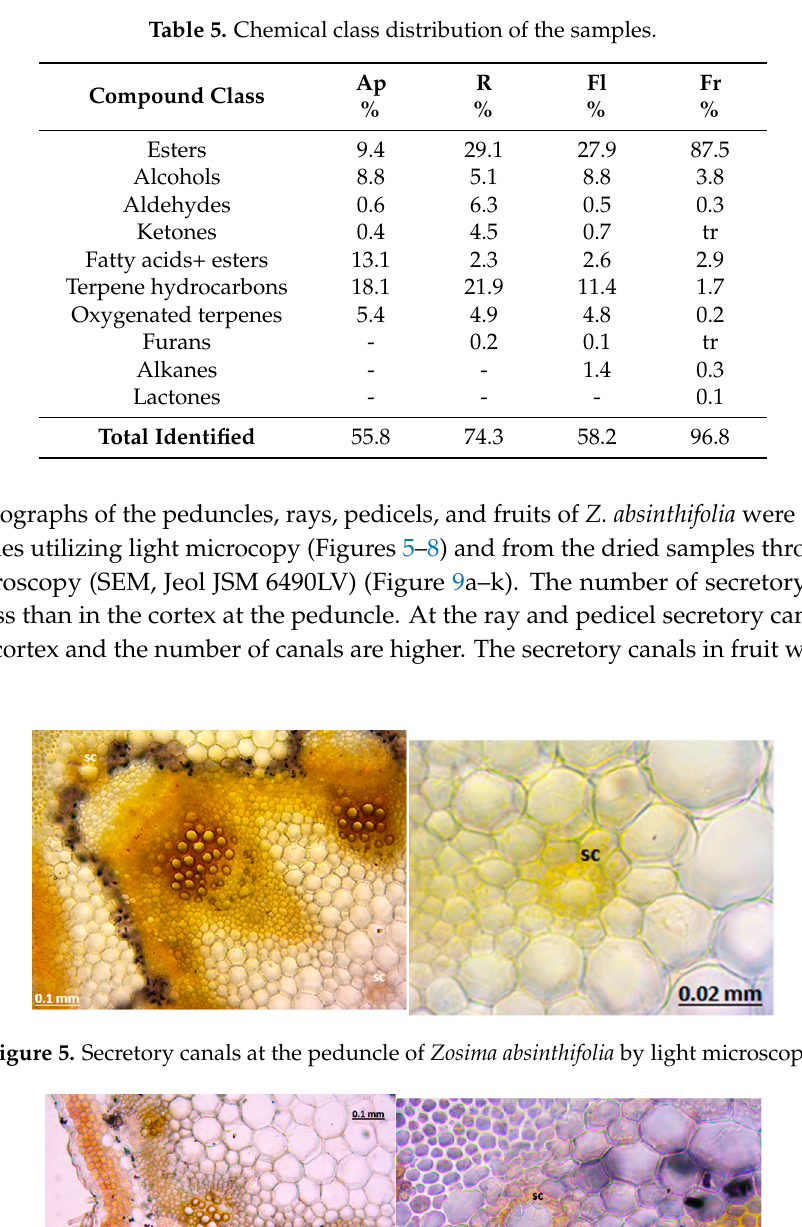
Figure 7. Secretory canals at the pedicel of Zosima absinthifolia by light microscopy. Figure 8. Secretory canals at the fruit of Zosima absinthifolia by light microscopy. Secretory structures of stem, leaf, flower and fruit samples of Z. absinthifolia were studied in detail using light and scanning electron microscopy. The plant has secretory trichomes in the leaf, stem, pedicel and fruit. There are two types of glandular trichomes; capitate trichomes and sessile peltate trichomes. The capitate trichomes were identified on the leaf, pedicel and stem, peltate trichomes on pedicel and fruit. The capitate trichomes are composed of multi basal cells, a long stalk cell with the unicellular secretory head. Peltate trichomes exhibit a flattened head in the pedicel or a granular head in fruit formed by several cells arranged in a circle (Figure 9). Extrafloral nectaries are found on the pedicel. The secretory ducts show a lumen surrounded by a layer of specialized cells in fruit. Excretion secretory system organs including crystals are observed in the fruit.